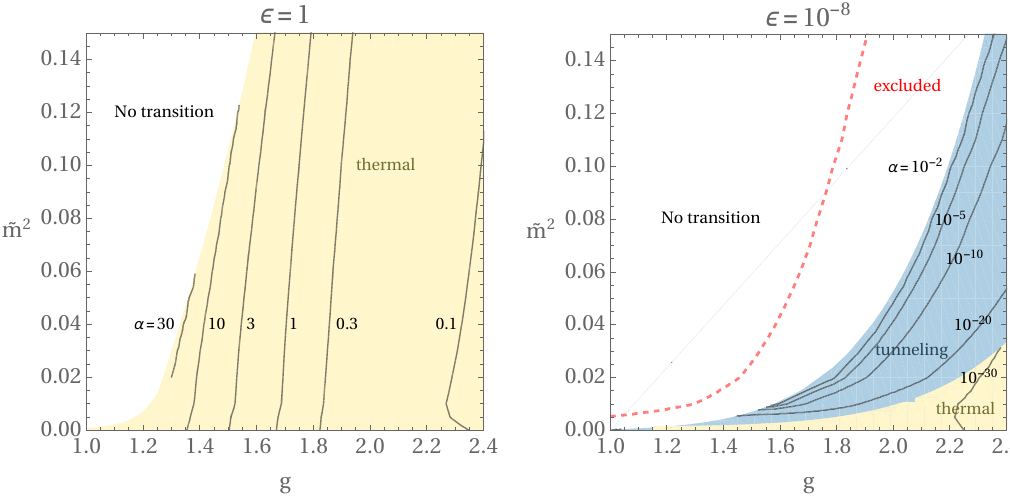
Figure 5 . The type of phase transition that occurs (yellow: thermal, blue: tunnelling) over the hidden sector parameter space for w = 1 GeV, when the hidden sector is at the same temperature as the visible sector (left) and when the hidden sector is much colder with (cid:30) = 10 contours give the values α for the transitions. In the white region no phase transition takes place. For cold hidden sectors there are models that cannot lead to an acceptable cosmological history, as described in the